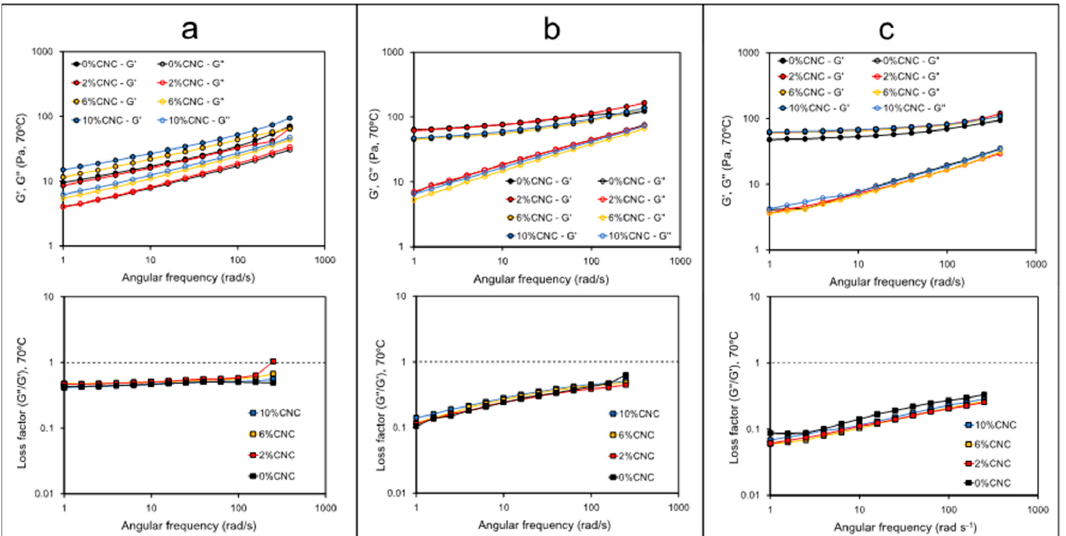
Figure 4. G’ and G’’ ( a ) and loss factor (G’’/G’) ( b ) assessed as a function of angular frequency in gelatinized starch samples at 70 °C.